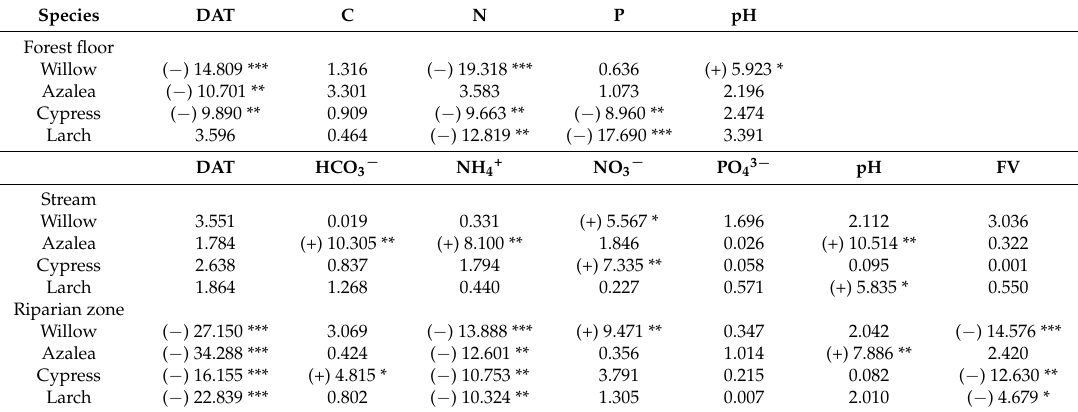
Table 5. F -values for the regression analysis between cellulose degradation rate (%/month) and local-scale environmental factors during litter decomposition in each ecosystem type across the two-year